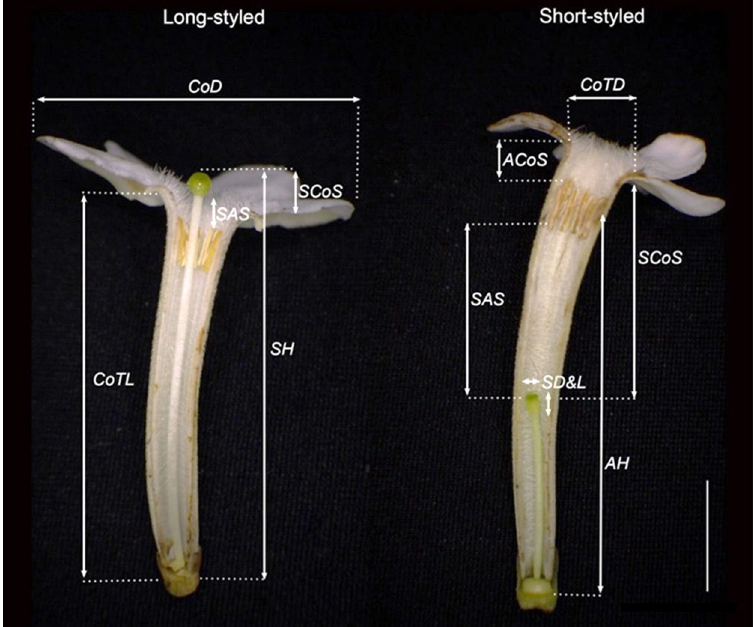
Figure 1. Floral morphology of Guettarda speciosa , showing the position of anther and stigma, and measurements of floral characters. CoD: corolla diameter; CoTL: corolla tube length; CoTD: corolla tube diameter; SCoS: stigma-corolla separation; SAS: stigma-anther separation; AH: anther height; SH: stigma height; CoAS: corolla-anther separation; SD&L: stigma’s diameter and length. Bar = 10 mm.